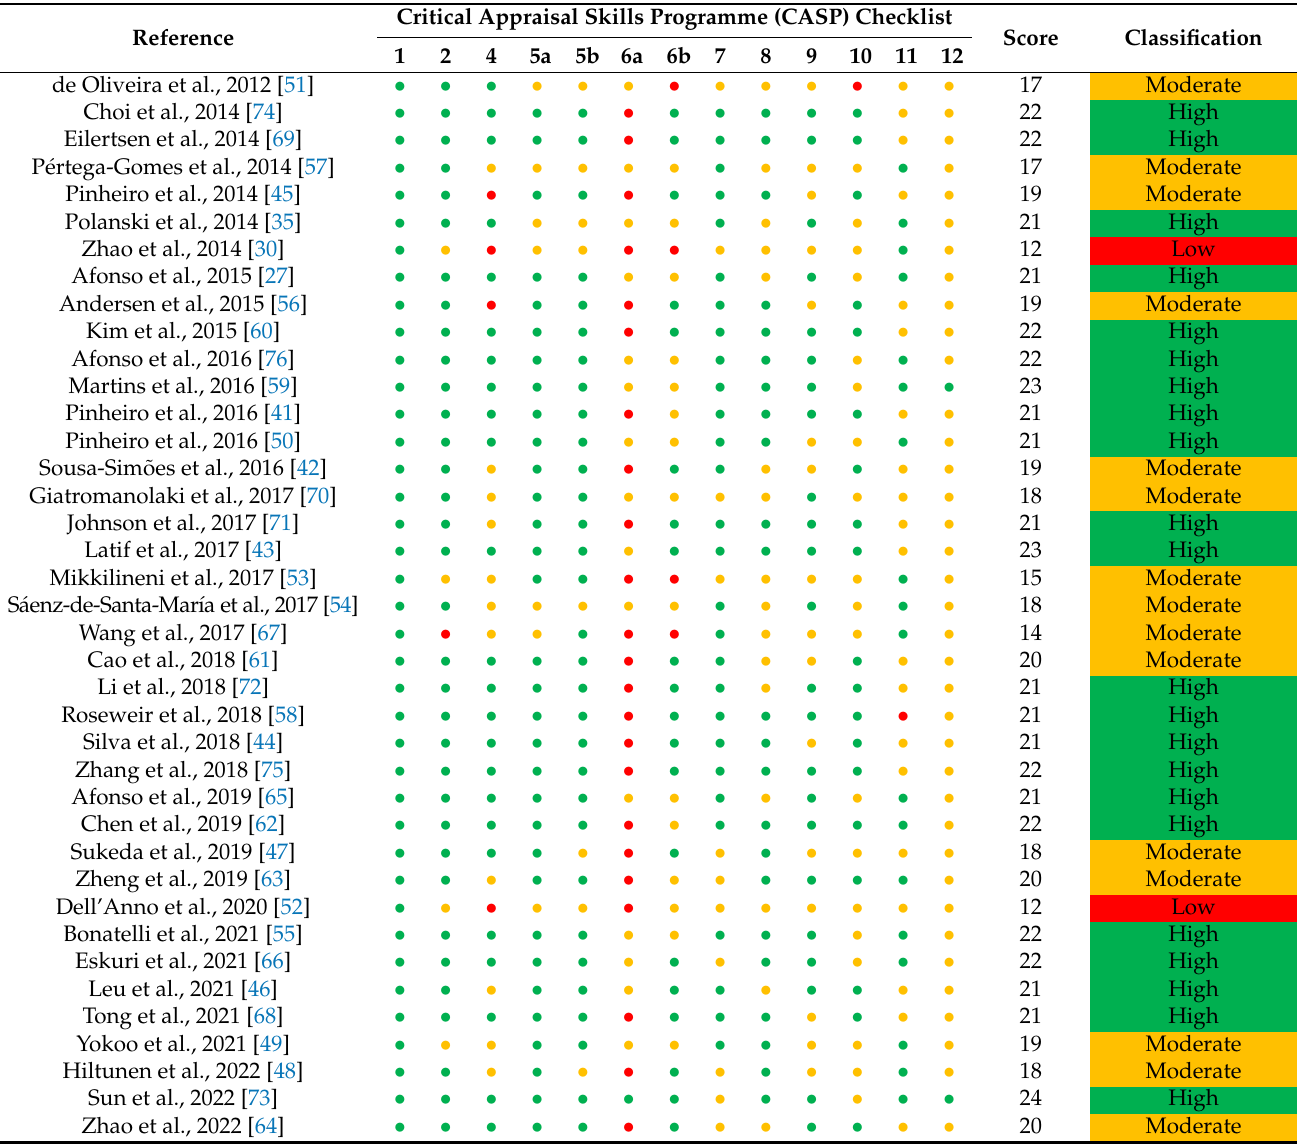
Table 3. Quality assessment of selected studies based on the guidelines from the Critical